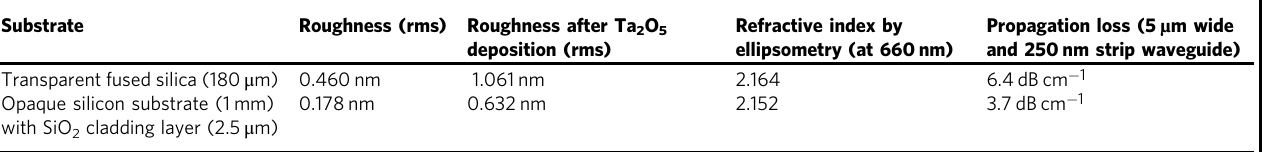
Graphs and images for determining the roughness and refractive index of the substrate and fi lm are shown in Supplementary Fig.